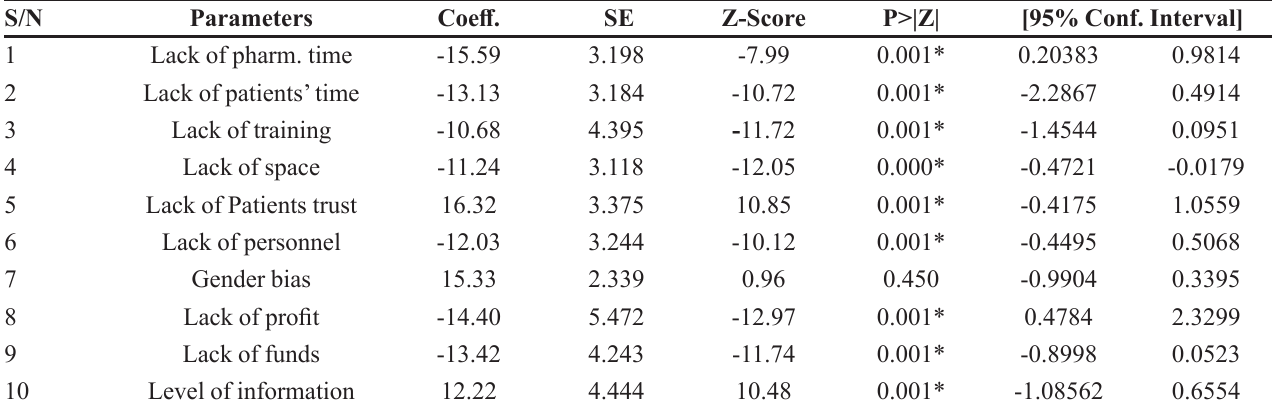
TABLE V - Results of Ordered Probit Regression Analysis showing the effect of certain barriers to community